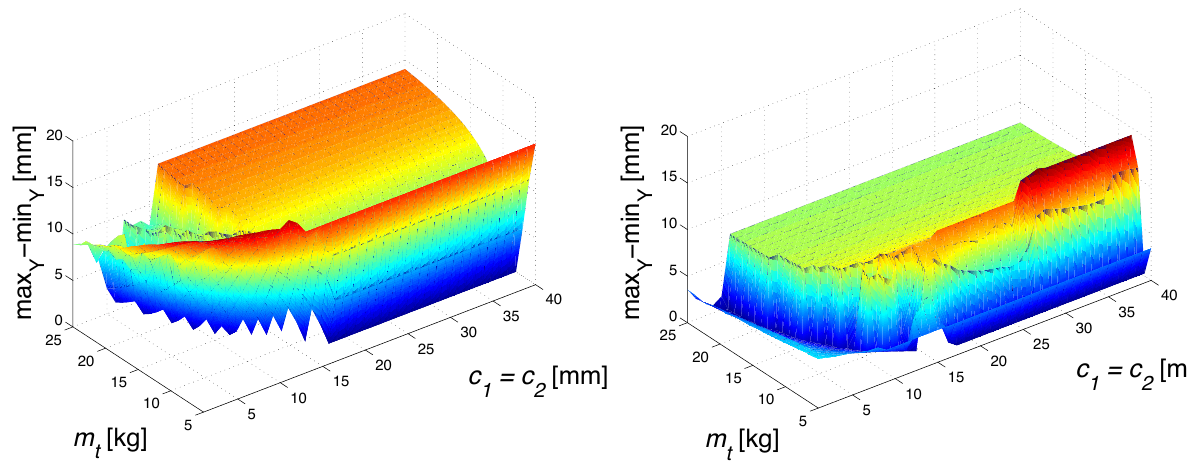
Fig. 4 Peak-to-peak vibration of the rotor frame dependent on the clearance c 1 = c 2 and the mass of the impact element m t for the excitation frequency (left) ω = 100 rad s − 1 and (right) ω = 115 rad s − 1 . such manipulation is not easy to accomplish from the technological point of